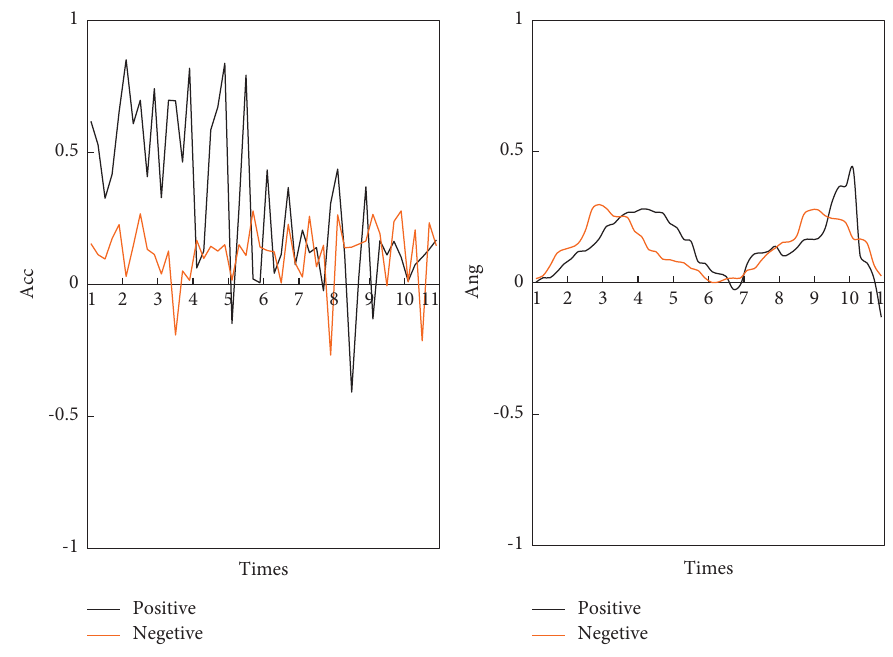
Figure 6: Acceleration and angle information. Table 3: Performance comparison of detection operators.